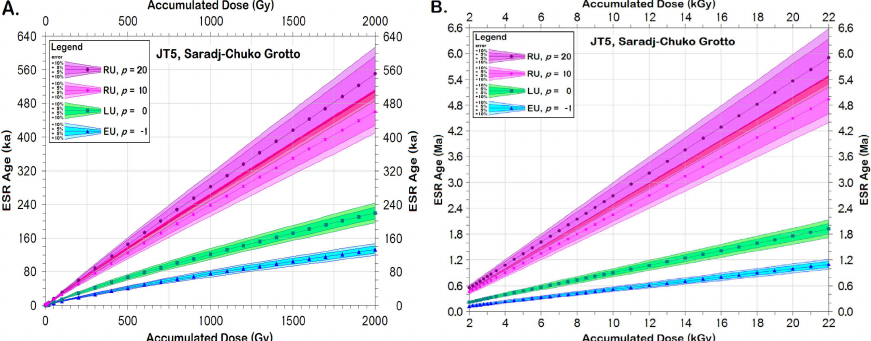
Figure 8. Calculated ages vs. accumulated doses, A Σ , JT5, Saradj-Chuko Grotto, Russia . Using the preliminary volumetrically averaged sedimentary dose rates, D sed, β ( t ) and D sed, γ ( t ) , ESR ages were calculated for JT5 at: ( A ) A Σ = 0.0–2.0 kGy ( B ) A Σ = 2.0–22.0 kGy As A Σ rises, so do the calculated ages, with a nearly linear function. Assuming that an early U uptake model (EU, p = − 1) describes the